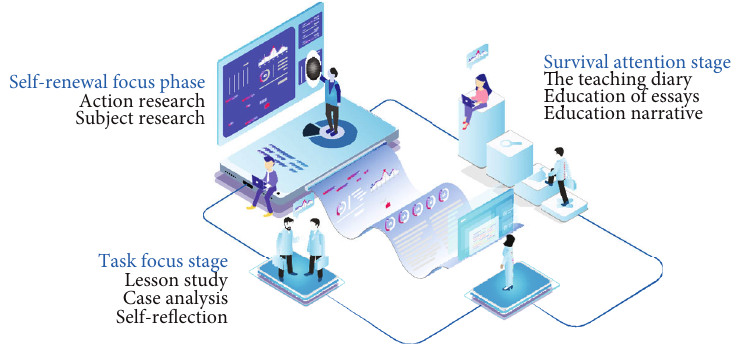
Figure 1: The technology based on big data analysis. Table 1: Statistics of students ’ college entrance examination